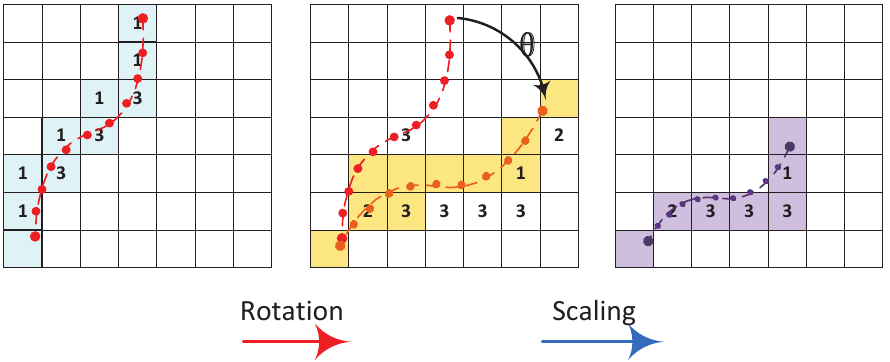
Figure 5. Illustration of different trace transformation